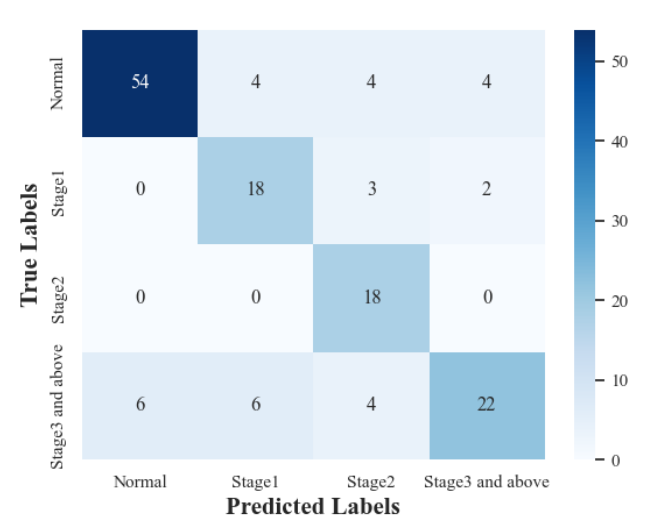
Figure 3. Confusion matrix of our ROP staging